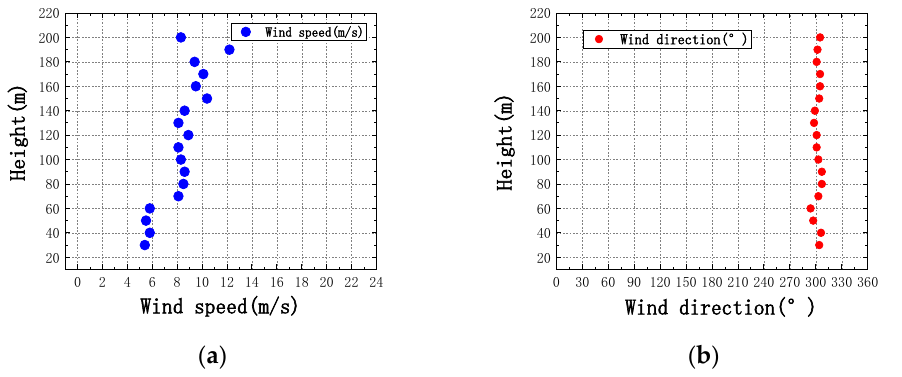
Figure 7. Simultaneous wind profile and wind direction angle: ( a ) wind profile with α = 0.35; ( b ) height distribution of the wind direction angle.